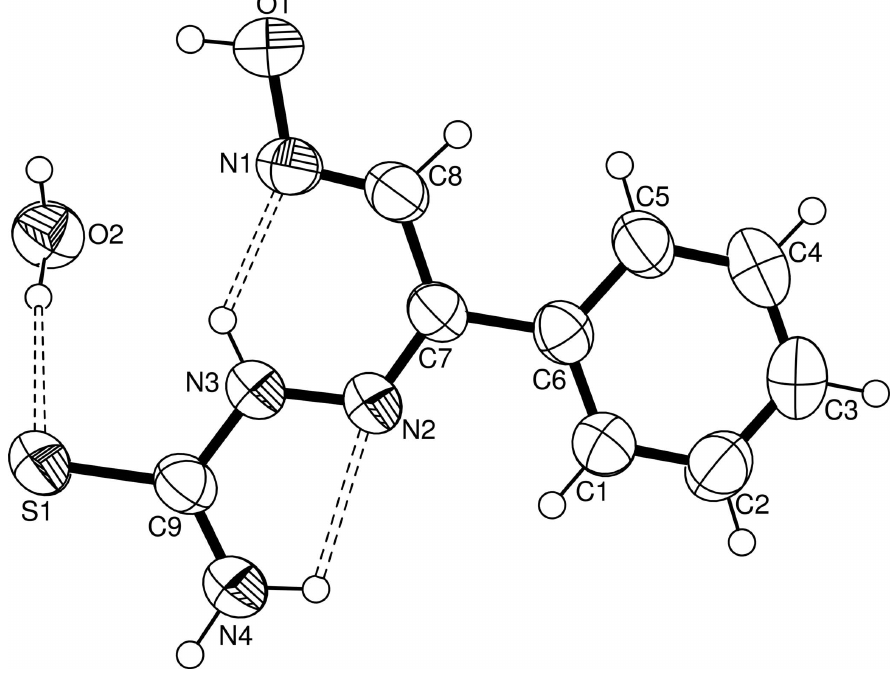
The molecular structure of the title molecule with the atom-numbering scheme. Displacement ellipsoids are drawn at the 50% probability